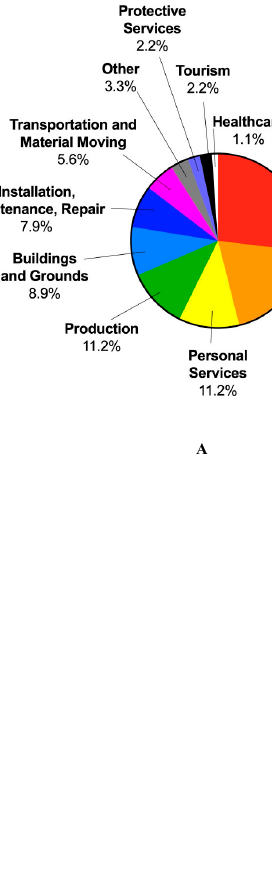
Table 5. Number of accident-related injuries and fatalities reported per month per